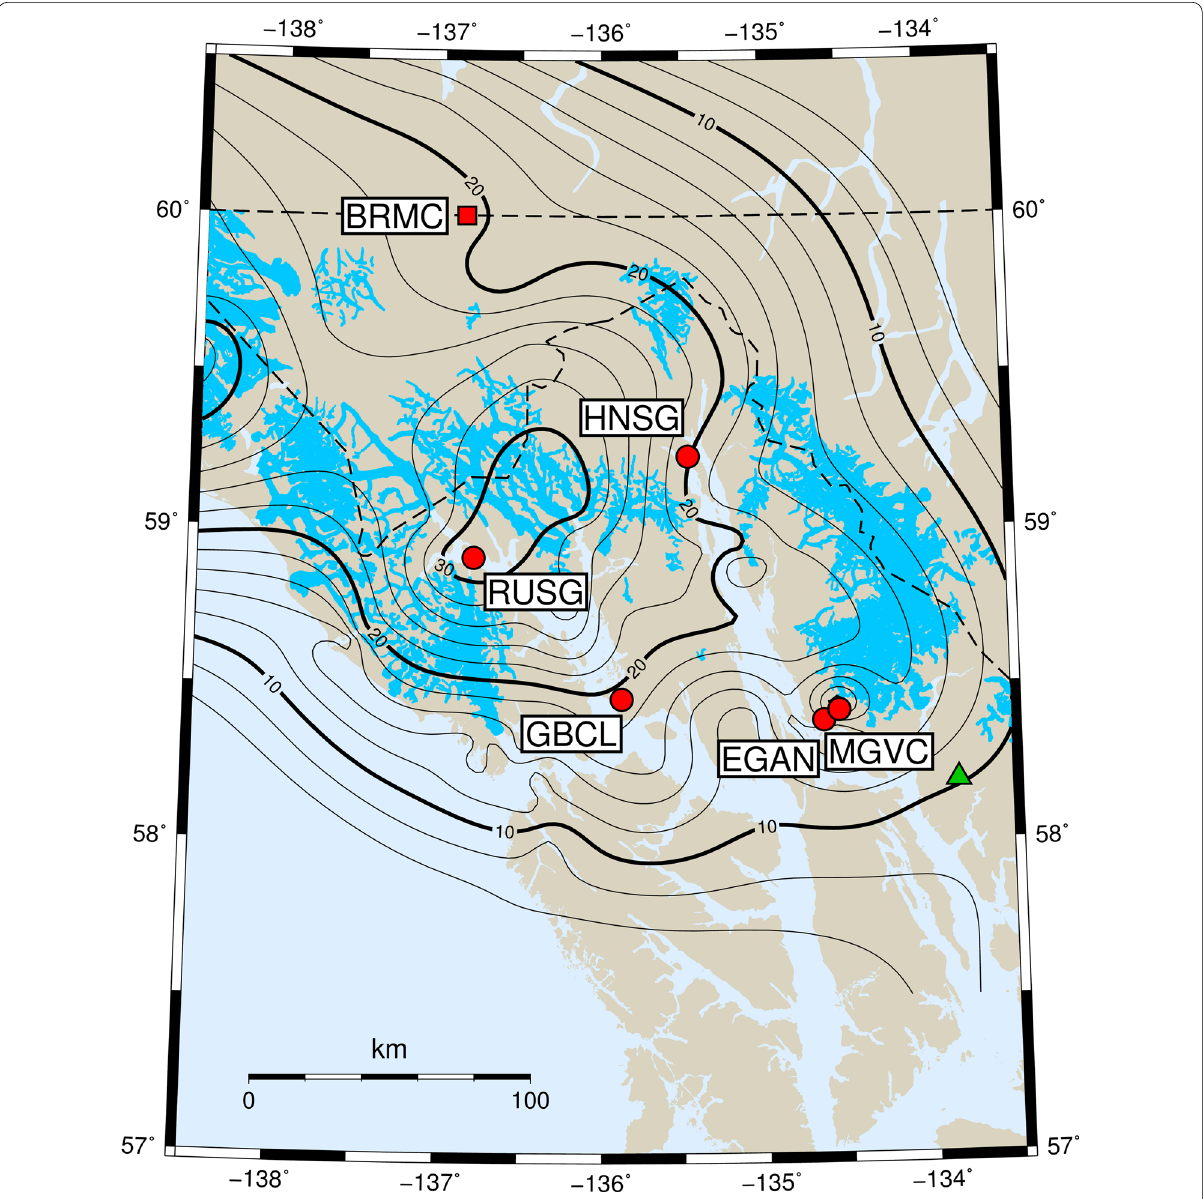
Fig. 1 AG points in SE-AK. Red circles and squares indicate the gravity points at which AG was repeatedly measured in 2006–2015 and 2007–2015, respectively. The cyan areas and contour lines indicate the glacier distribution of the UAF07’s PDIM model (Larsen et al. 2007) and the rate of ground uplift in mm/yr (Larsen et al. 2005) at intervals of 2 mm/yr, respectively. The green triangle indicates Long Lake’s weather station belonging to the National Water and Climate Center, and dashed lines indicate the borders of countries and